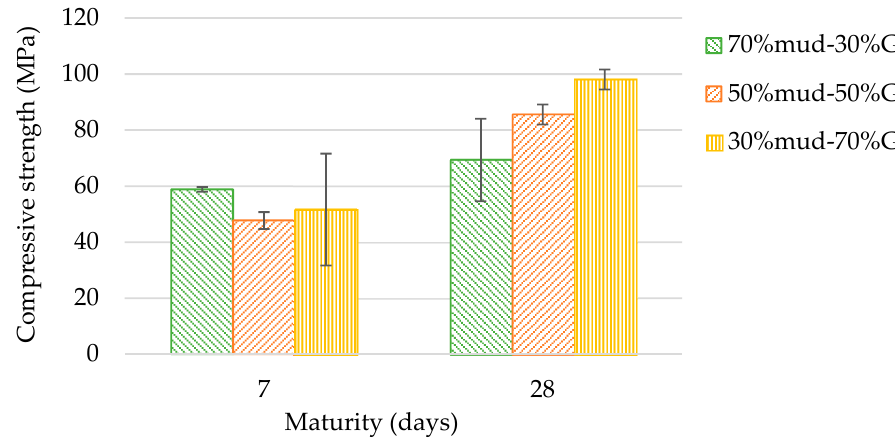
Figure 4. Compressive Strength vs. Maturity for the 3 DM/GGBS mixtures developed.